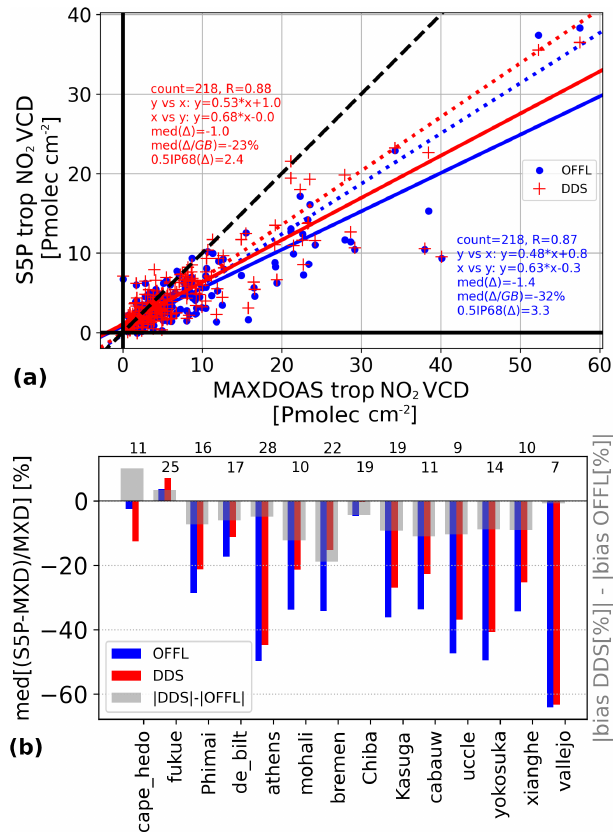
Figure 16. Similar to Fig. 15 but for S5P/TROPOMI vs. MAX- DOAS tropospheric NO 2 column measurements, which require no photochemical adjustment. Sites in panel (b) are ordered along an increasing MAX-DOAS tropospheric